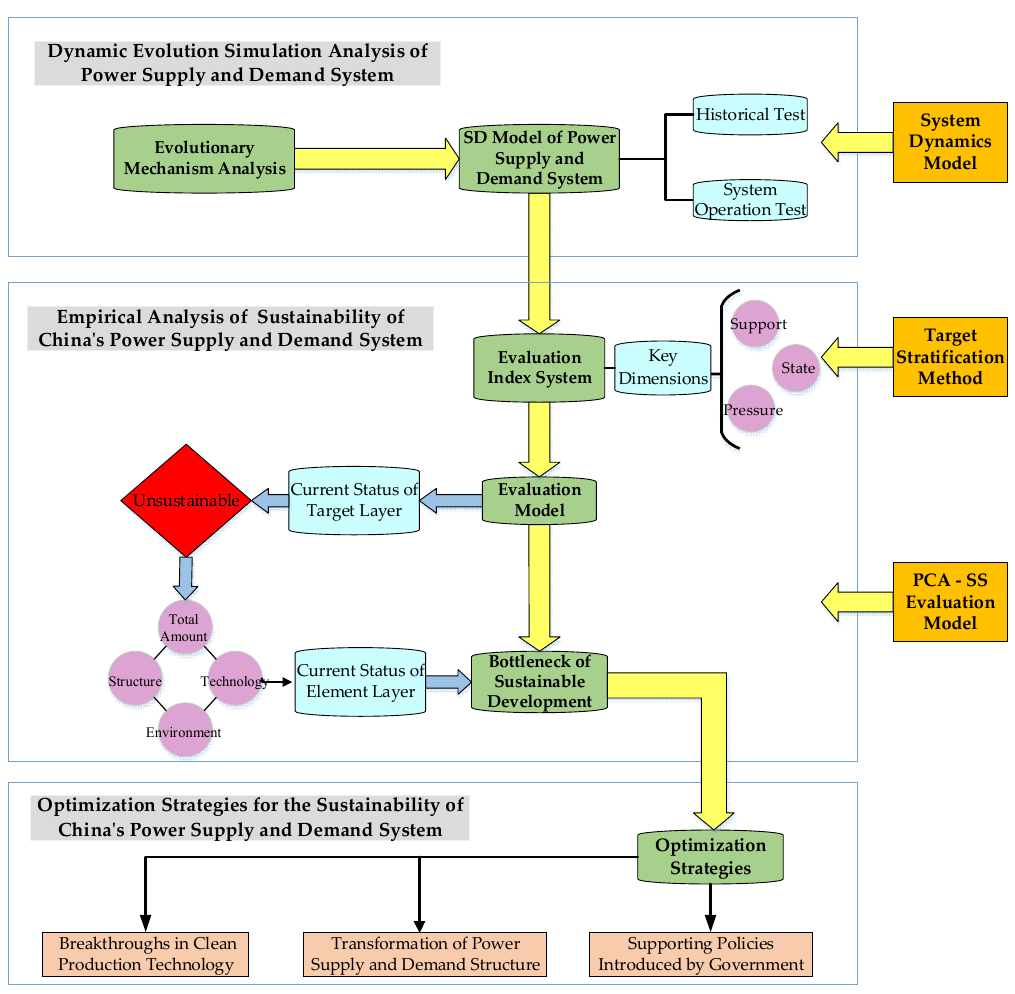
Figure 4. The study process of sustainability of power supply and demand system.